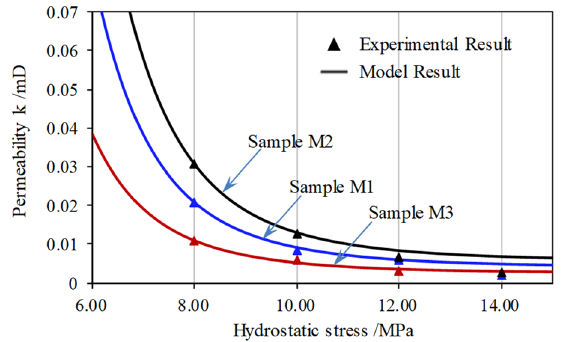
Figure 15. Comparison between the experimental data and model calculation results.